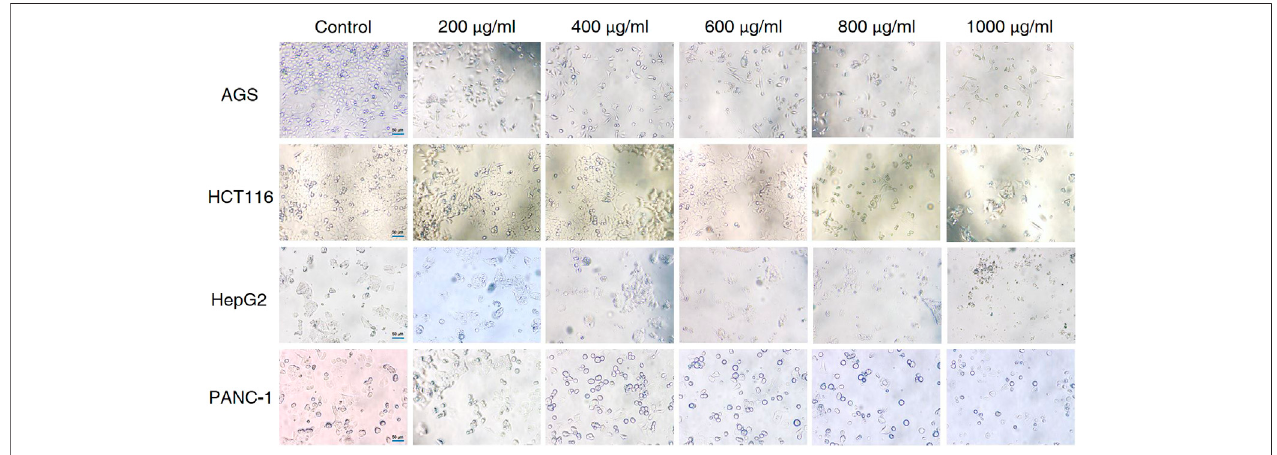
FIGURE3| EffectofCCS2 onthemorphologyoffourkindsofdigestivetract cancercells.Cellphotographsoffour kindsofdigestivetract cancercellstreatedwith CCS2 (0, 200, 400, 600, 800, and 1000 μ g/ml) for 48 h. Scale bar = 50 μ m.